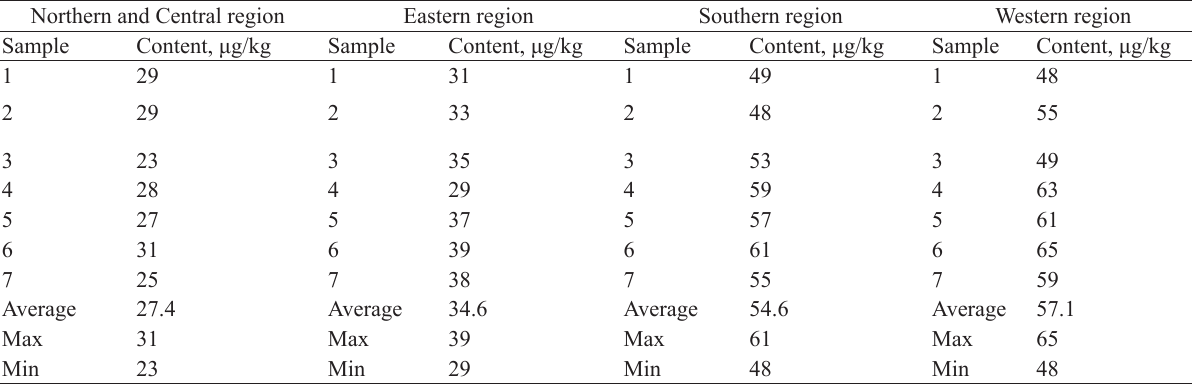
Table 2 Lead contents in raw milk samples Northern and Central region Sample